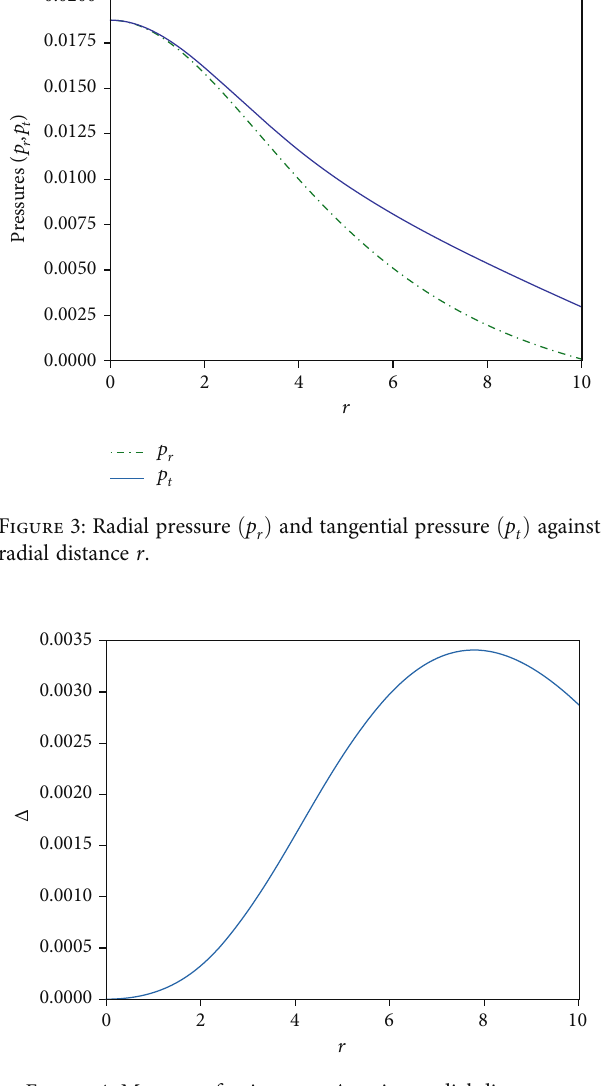
Figure 4: Measure of anisotropy Δ against radial distance r .